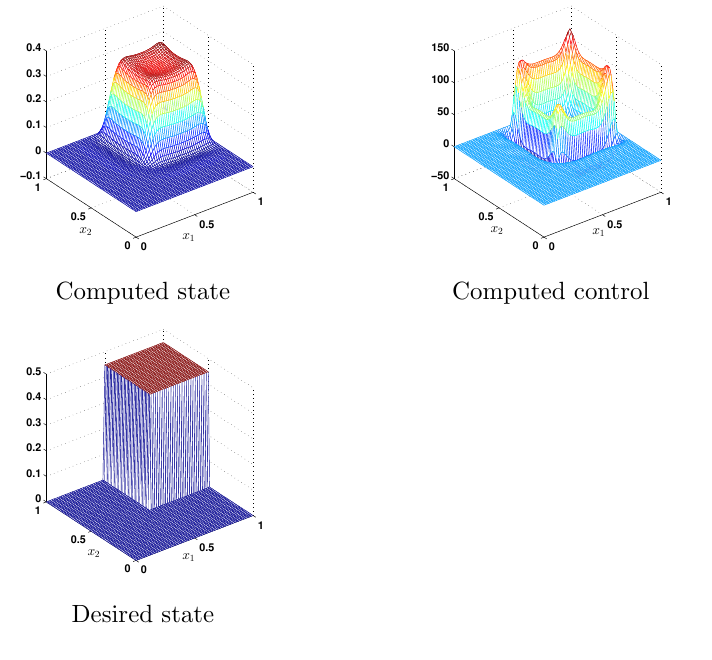
Figure 2. Problem 1: Surface plots of the desired state u d , the computed state u and the control v on a 64 × 64 grid and β = 10 −